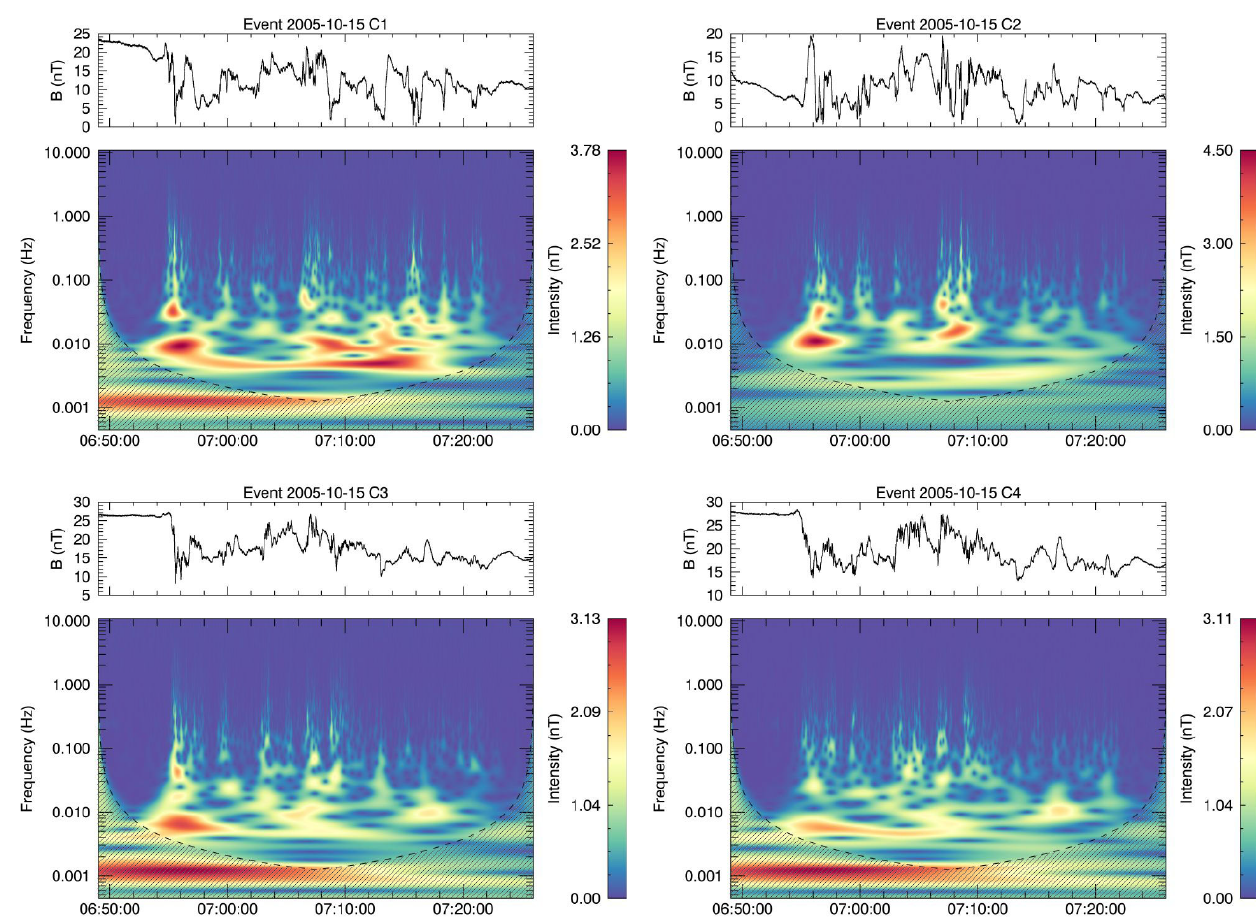
Figure 5. The results of wavelet analysis for event 15 October 2005. The cone of influence is shown by the shaded